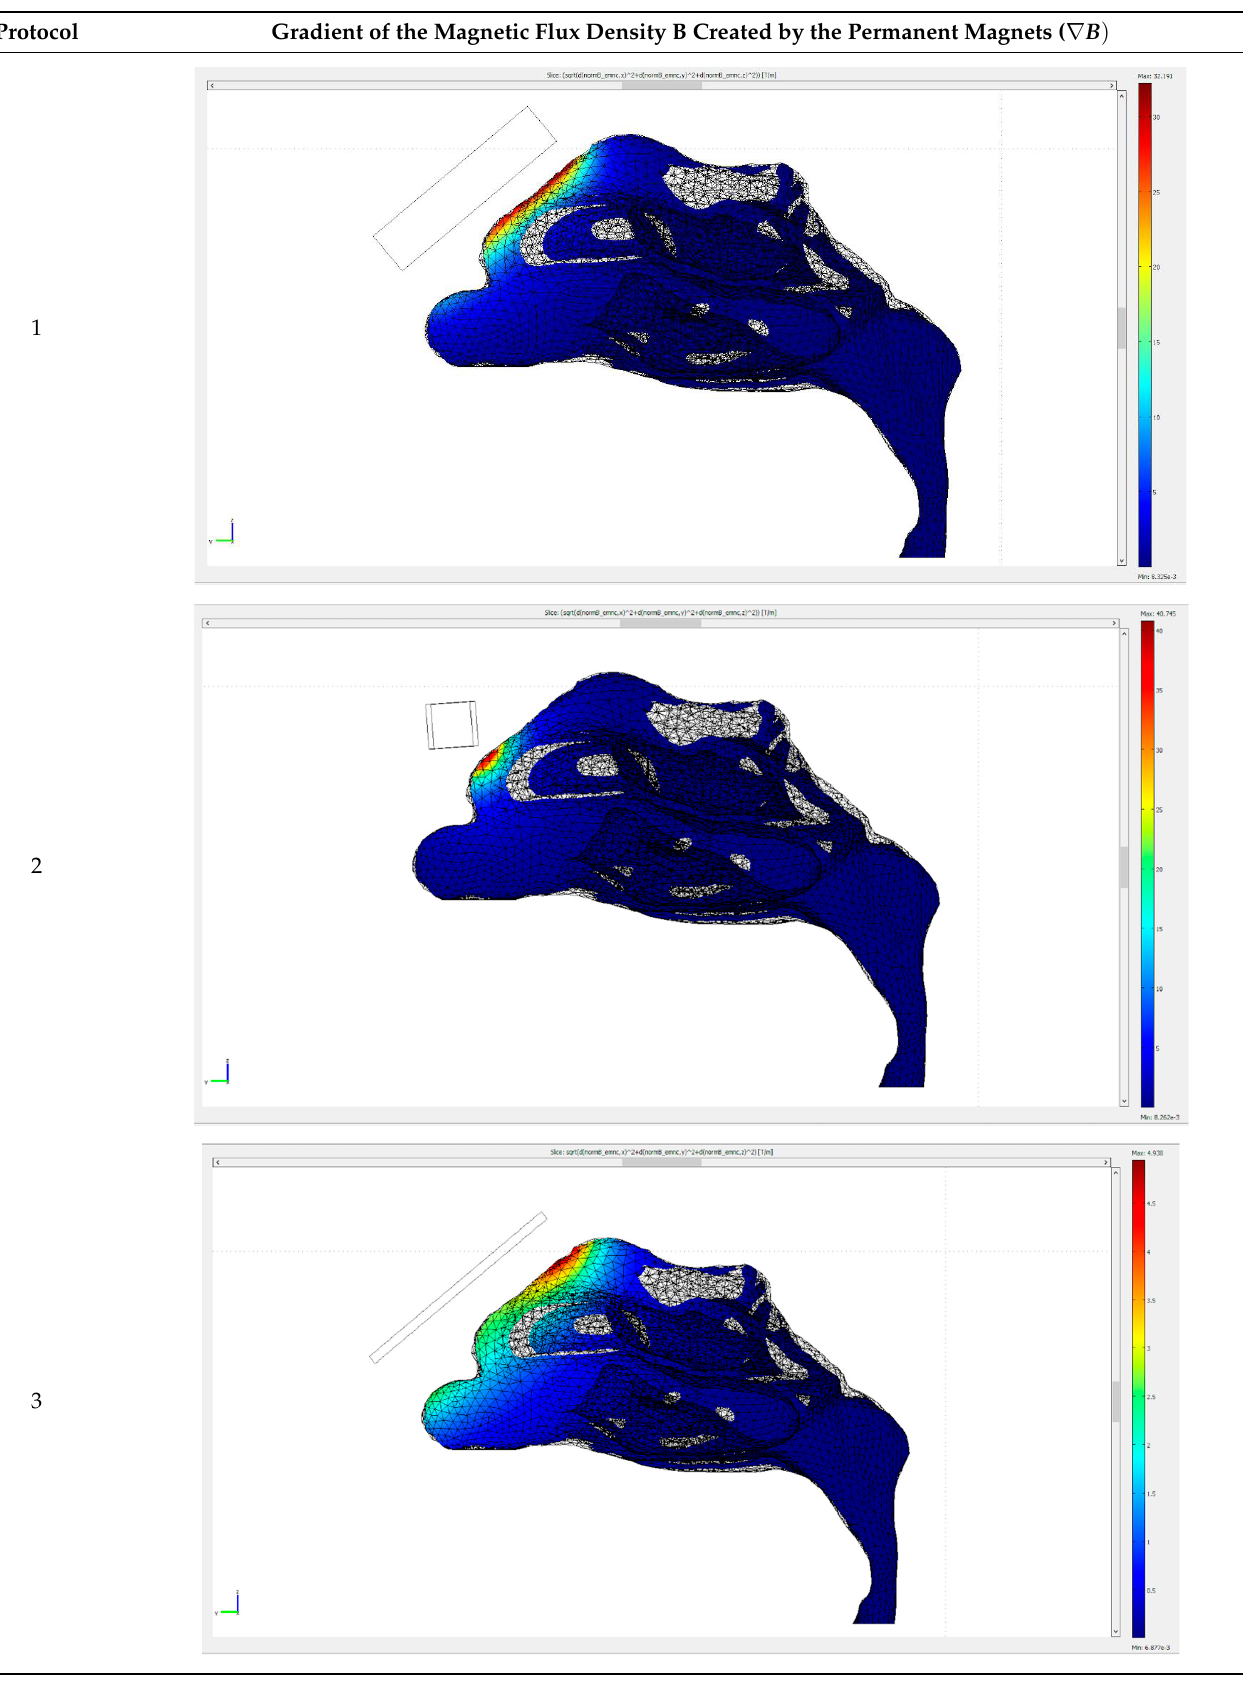
Table 2. The gradient of magnetic flux density generated by the static magnets (1.2 T ) for each protocol.